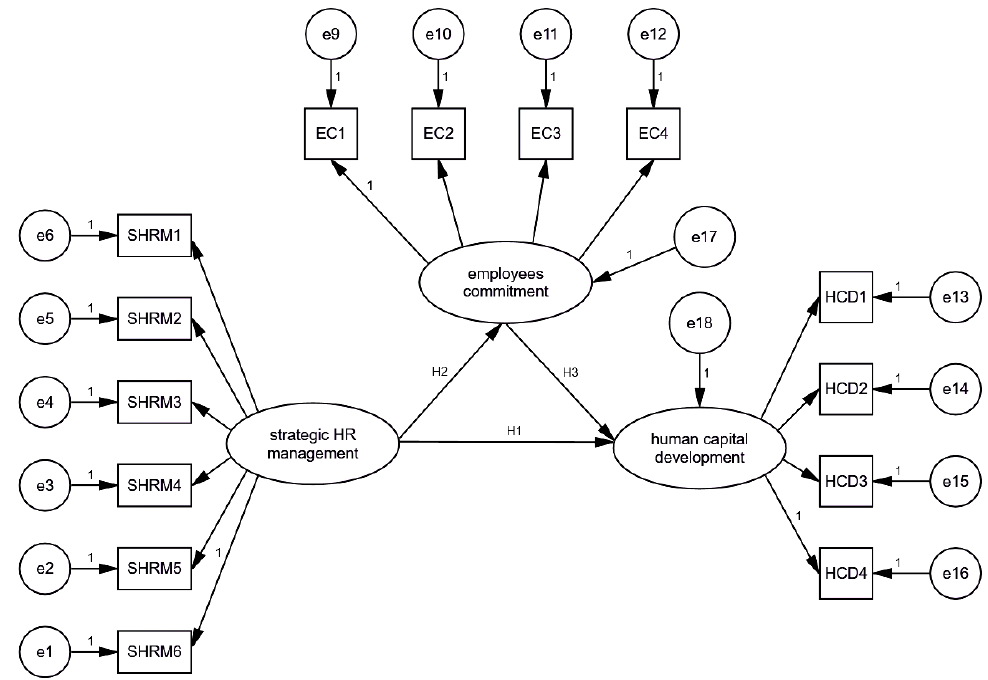
Figure 1. Conceptual model converted into AMOS